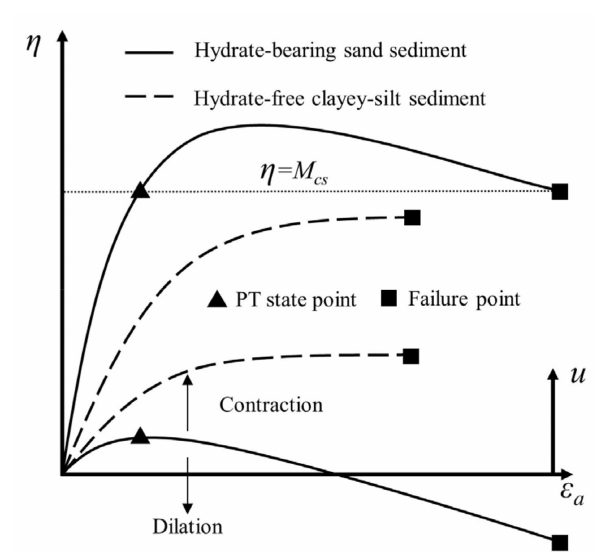
Figure 12. Stress ratio η versus A (cid:48) value relationship of sand sediments with ( a ) S h = 0%, ( b ) S h ≈ 30%, and stress ratio η versus A (cid:48) value relationship of clayey-silty sediments with ( c ) S h = 0%, ( d ) S h ≈ 30%.